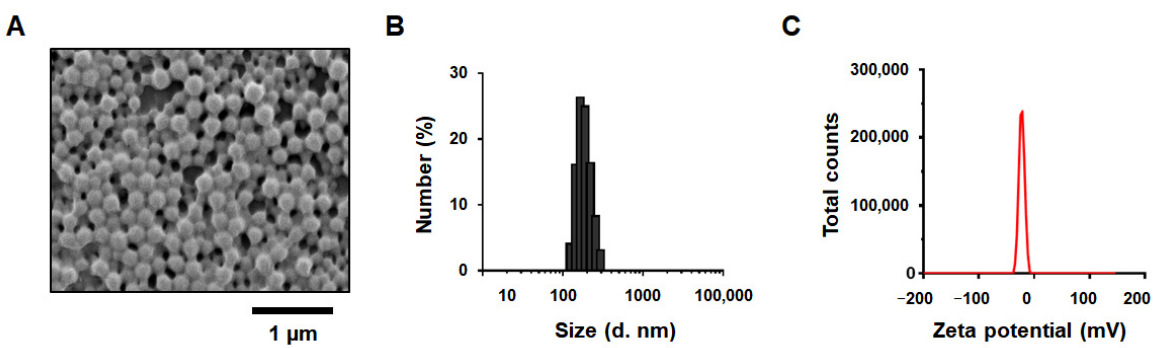
Figure 3. Characterization of physicochemical properties of CZ-PLGA-NPs. ( A ) The surface mor- phology of CZ-PLGA-NPs with a spherical shape examined using scanning electron microscopy (SEM). Scale bar = 1 µ m; ( B , C ) Distribution of ( B ) size (diameter) and ( C ) zeta potential values of CZ-PLGA-NPs.